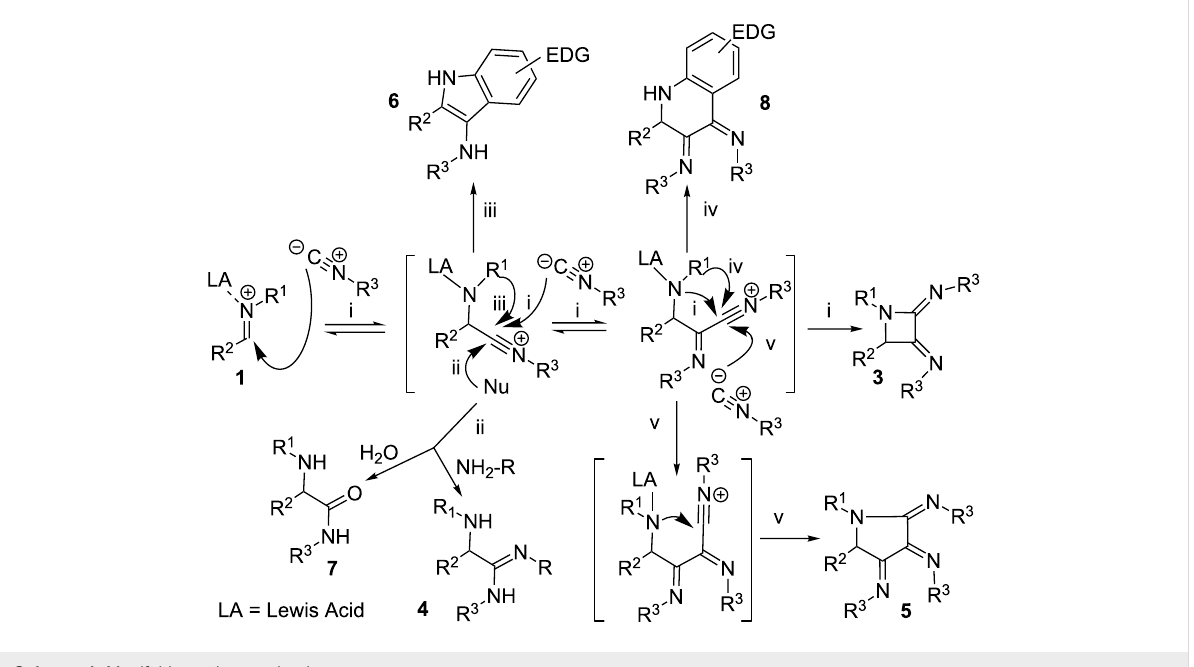
Scheme 4: Manifold reaction